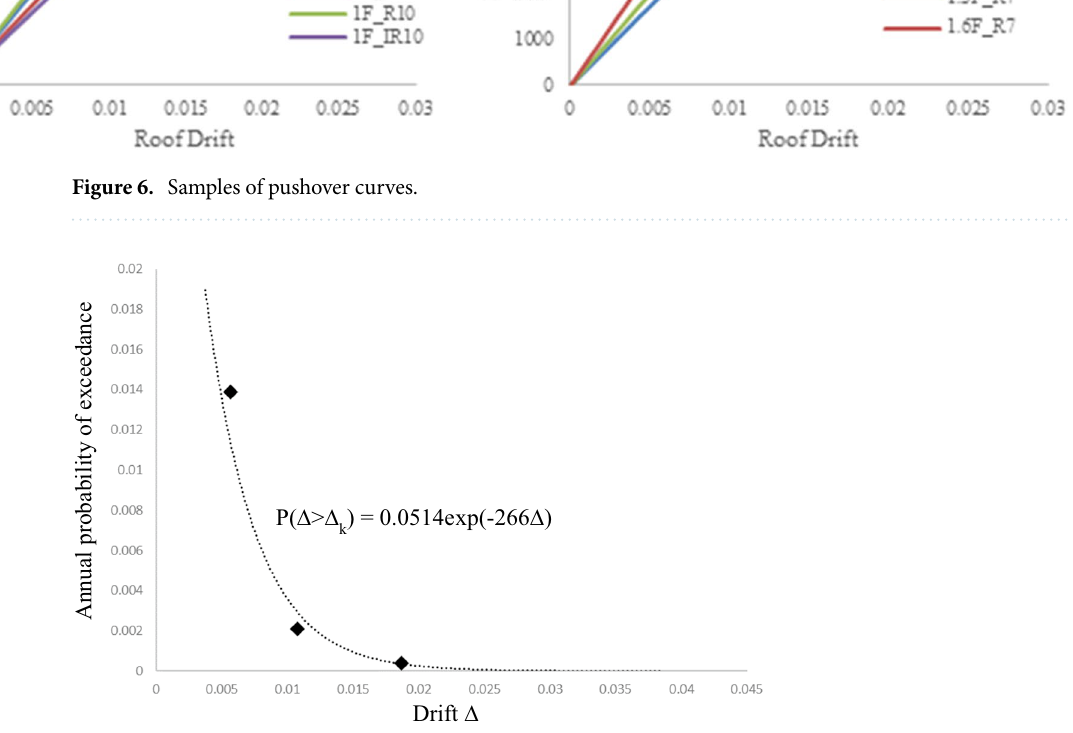
Figure 7. Calculation of annual exceedance probability ( P ) for each damage state (Case